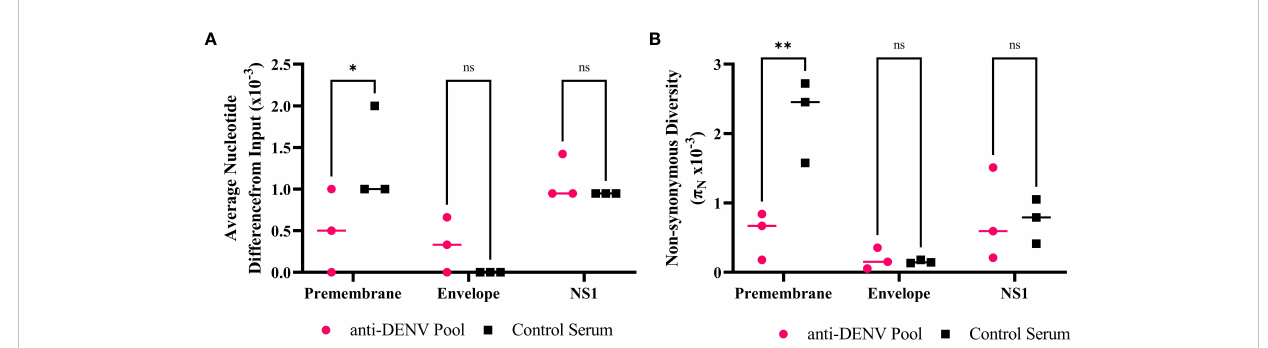
FIGURE 2 Anti-dengue virus (DENV) immune selection limits Zika virus (ZIKV) divergence and nonsynonymous diversity in the premembrane protein. (A) Divergence within the antibody binding region of passaged samples compared to the input virus. Each point represents the sequencing data from each passage 5 biological replicate. (B) Comparing the p n values at each protein with the antibody binding region of the passaged populations. Each point represents the sequencing data from each passage 5 biological replicate. Statistics were performed using a two-way ANOVA with a S ̌ ı ́ da ́ k's correction for multiple comparisons (* p = 0.043 ** p = 0.001). NS – nonstructural protein.